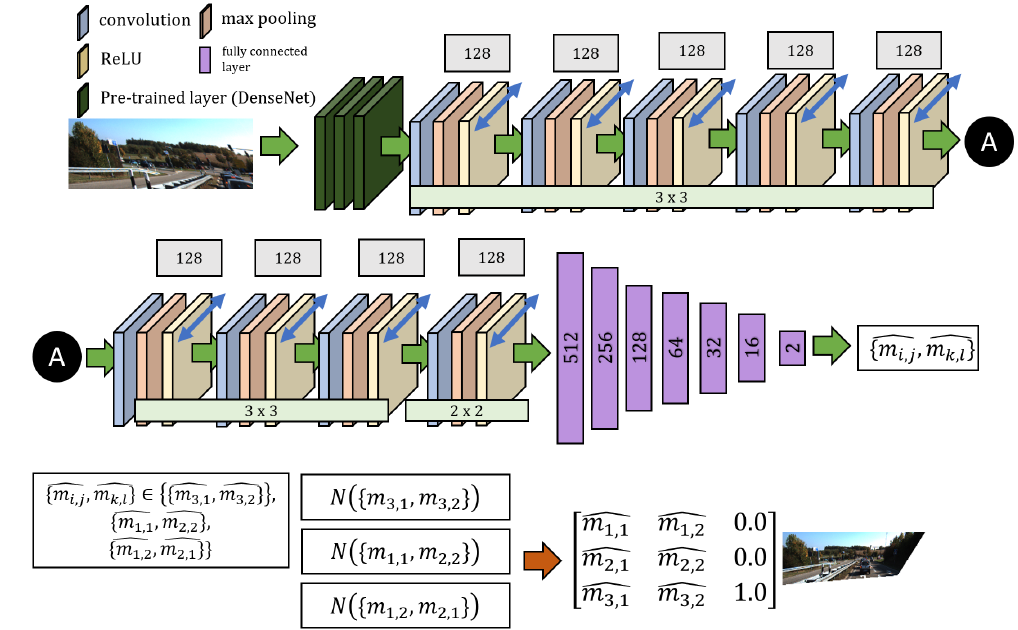
Figure 6. Architectural design of our network. There are three network instances that estimates an element in the transformation matrix (cid:98) M